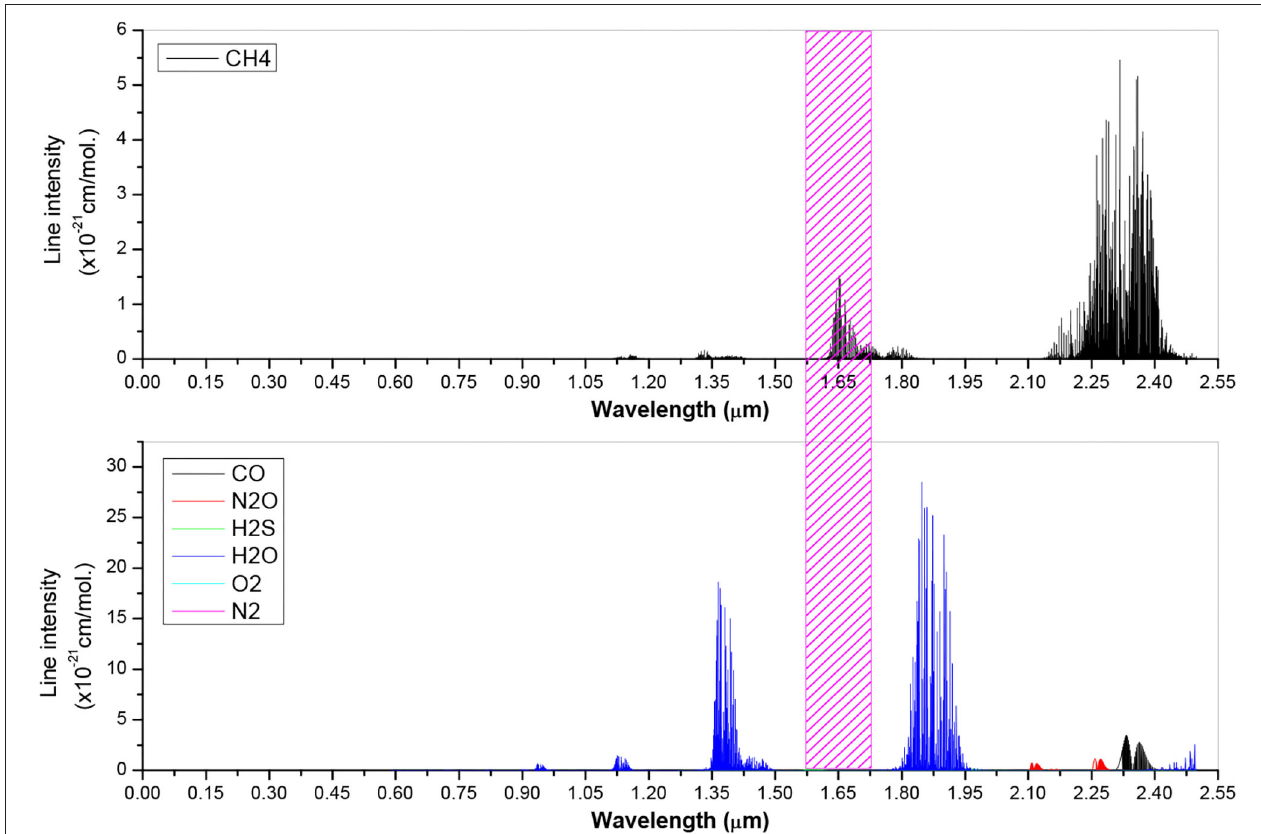
FIGURE 1 | HITRAN-based simulation of methane and other species absorption